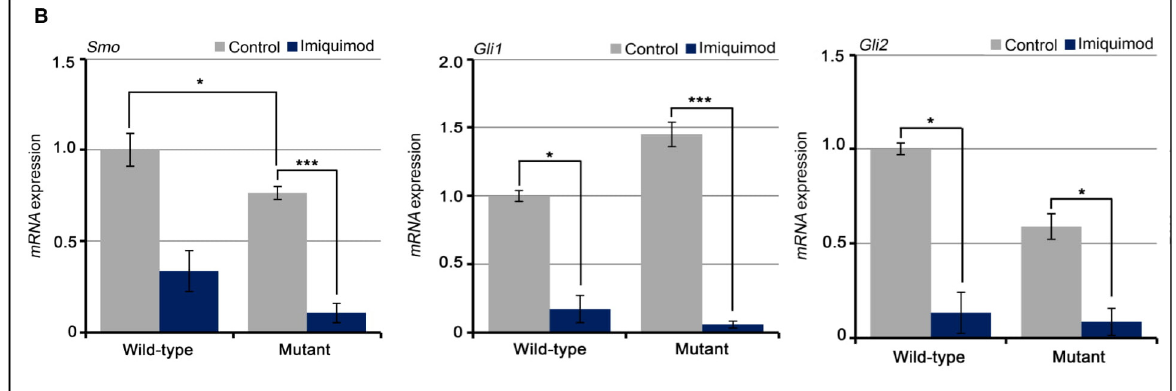
Figure 3. ( A ) MeWO cells were treated with increasing concentration of IMQ for 72 h and cell viability was evaluated by MTT assay. Table represents the IC50 value; ( B , C ) Sonic Hedgehog pathways, including SMO, GLI1 and GLI2 were evaluated by western blot (bar graphs in Supplementary Figure S1) and qRT-PCR analysis after IMQ treatment (1 μ M). Control: MeWo parental cell line; Wild-type: MeWo cell line transfected with SMO wild-type vector; MeWo cell lines: transfected with SMO mutant vector. * p < 0.1, *** p <